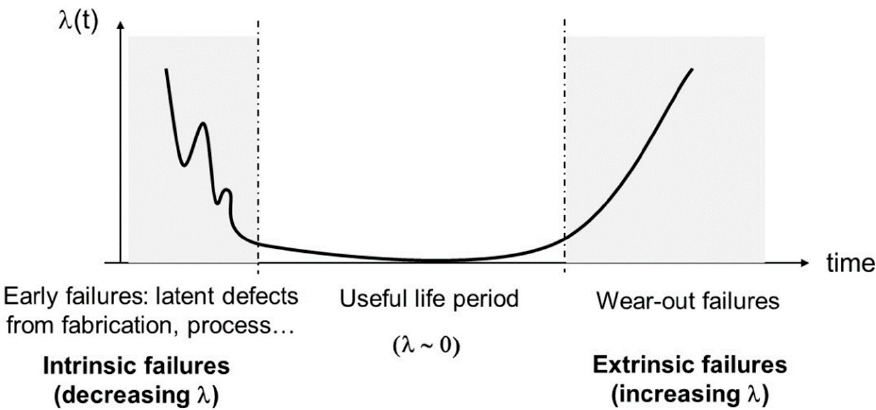
Figure 4. Variations of the time-dependent failure rate [38]. Reprinted with permission from ref. [38] © Elsevier. Copyright 2021 Advanced Laser Diode